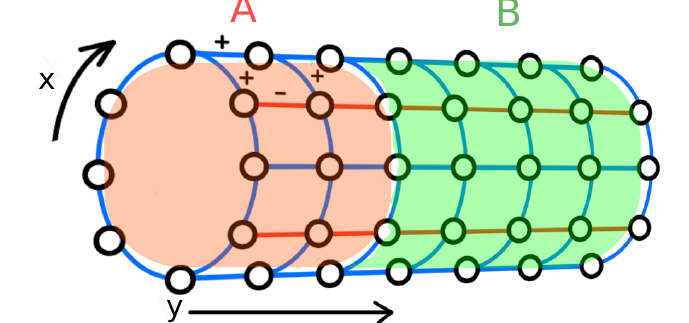
Figure 15: Lattice with periodic boundary conditions along the x direction. Red lines correspond to negative couplings, blue lines correspond to positive couplings. Two possible partitions A and B are higlighted in red and green